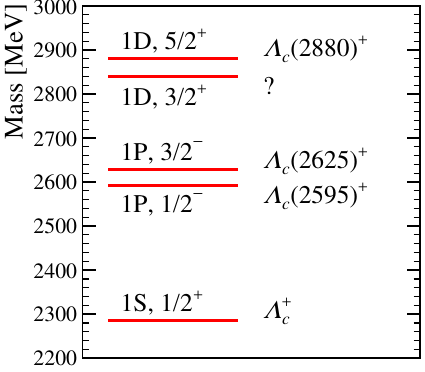
Figure 1 . Expected spectrum of the (cid:3) + ground state and its orbital excitations from a study based c on the nonrelativistic heavy quark-light diquark model [21], along with the observed resonances corresponding to those states